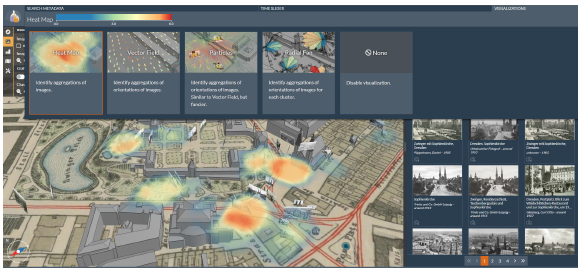
Figure 1. Application scenario for successfully oriented